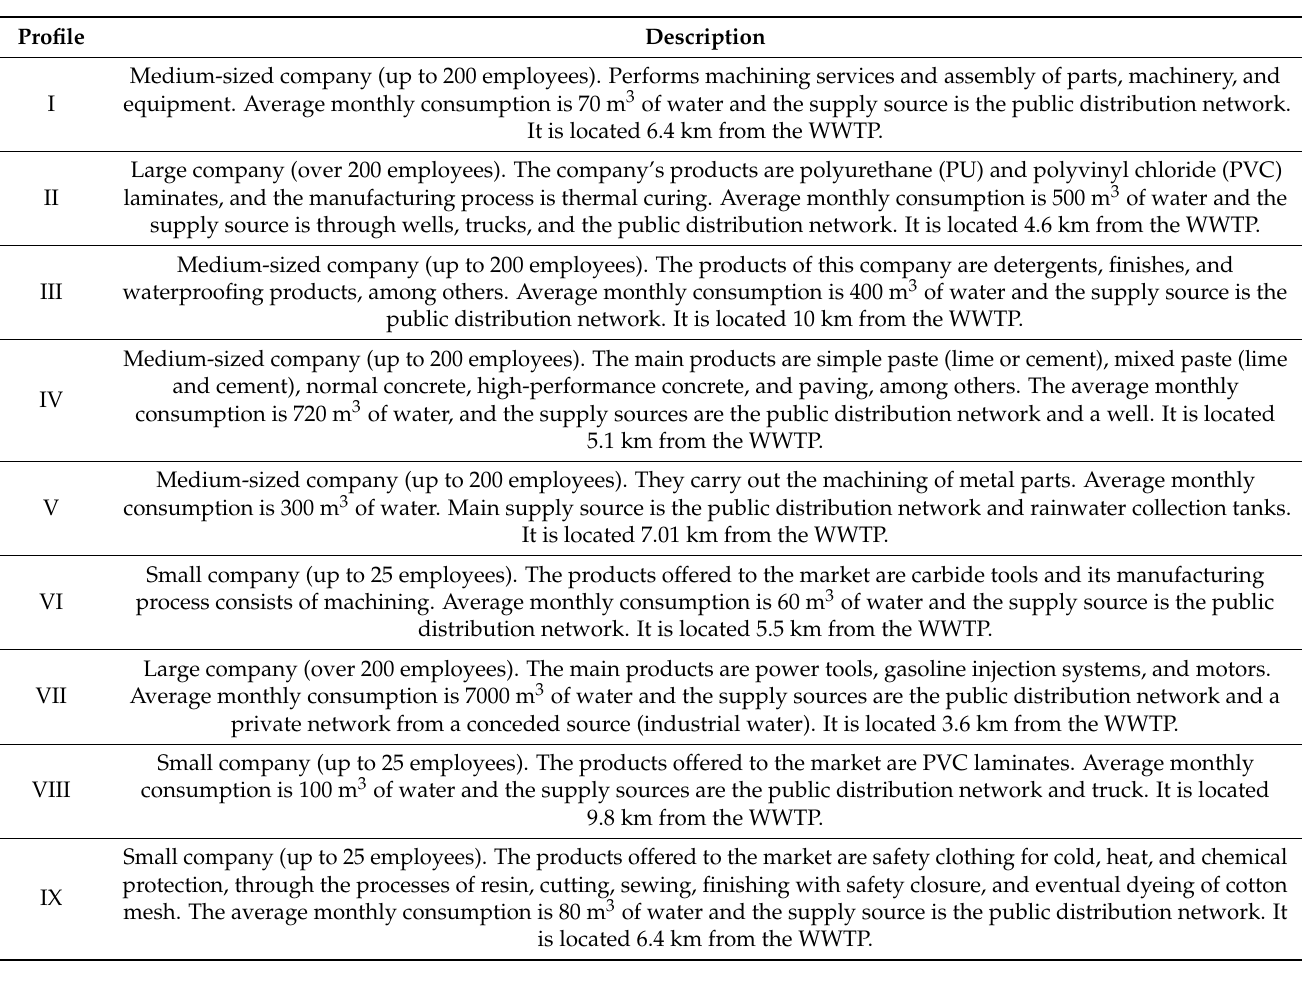
Table 3. Identification and description of potential end-users.